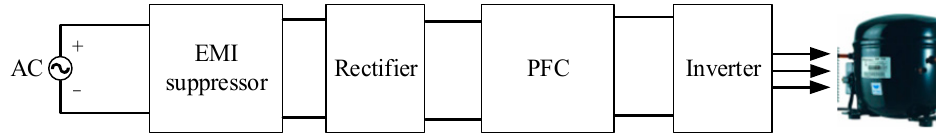
Figure 2. Configuration of the compressor drive developed.